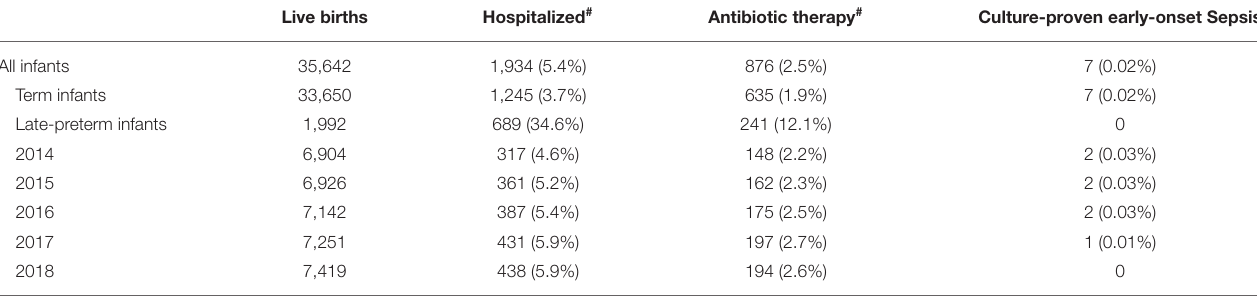
TABLE 1 | Overview of analyzed population.